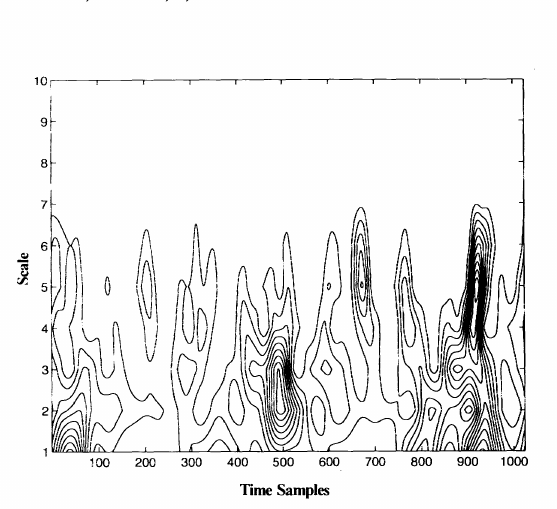
FIGURE 10 Square of time-scale distribution (faulty